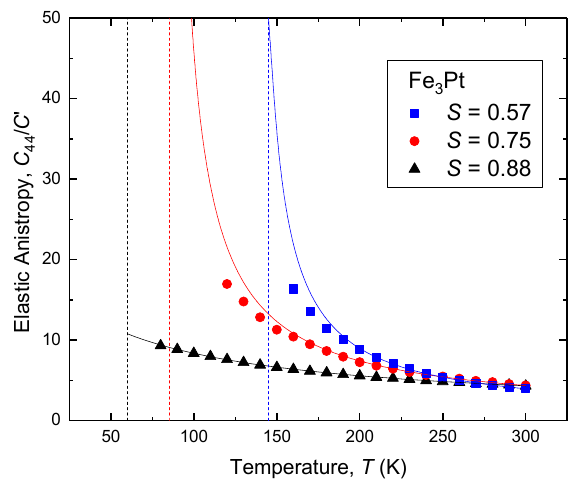
Figure 3. Temperature dependence of the elastic anisotropy of Fe 3 Pt with different degrees of order S . The vertical lines indicate the martensitic transformation temperature.